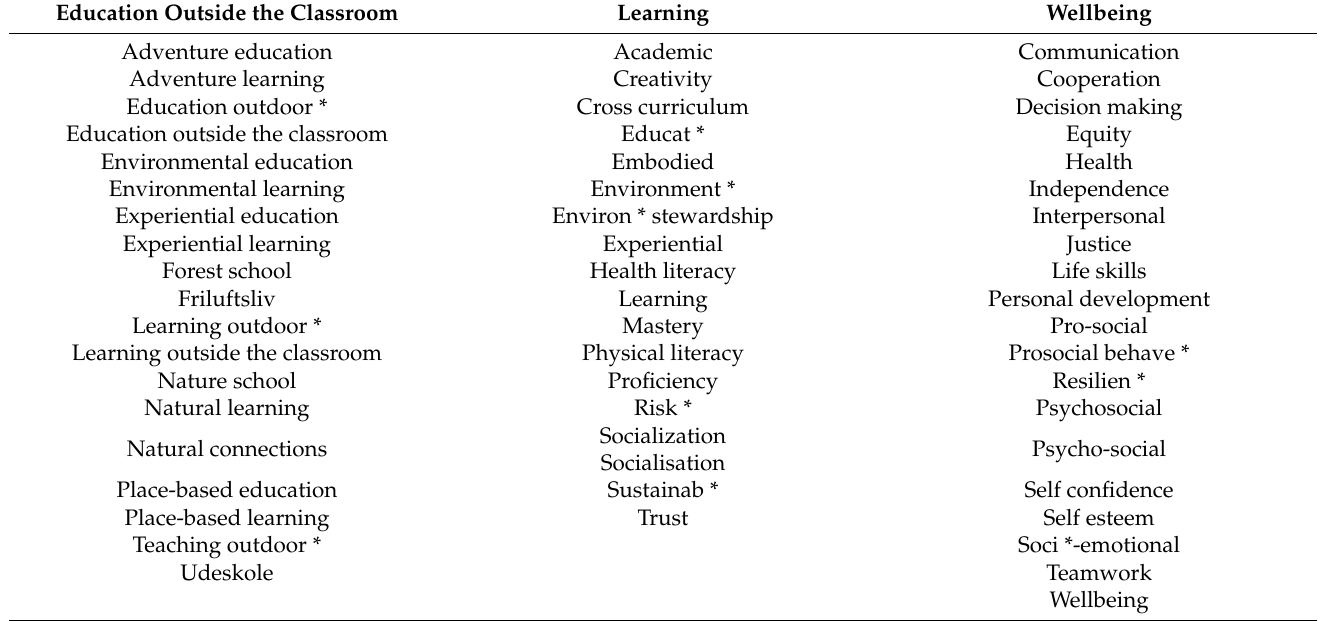
Table 1. Proposed search